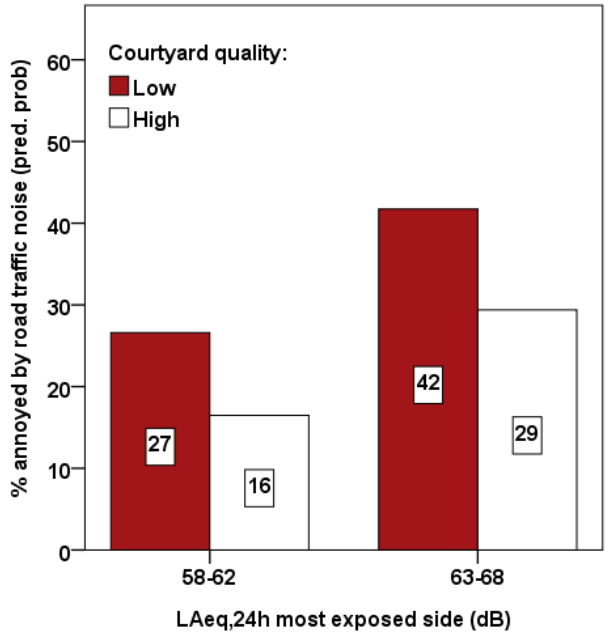
Figure. 2. Percentage of noise annoyed residents due to road traffic when being at home in relation to courtyard quality and sound